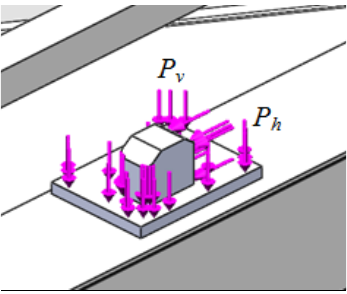
Figure 2. Load diagram of a fixed fitting on the flatcar.